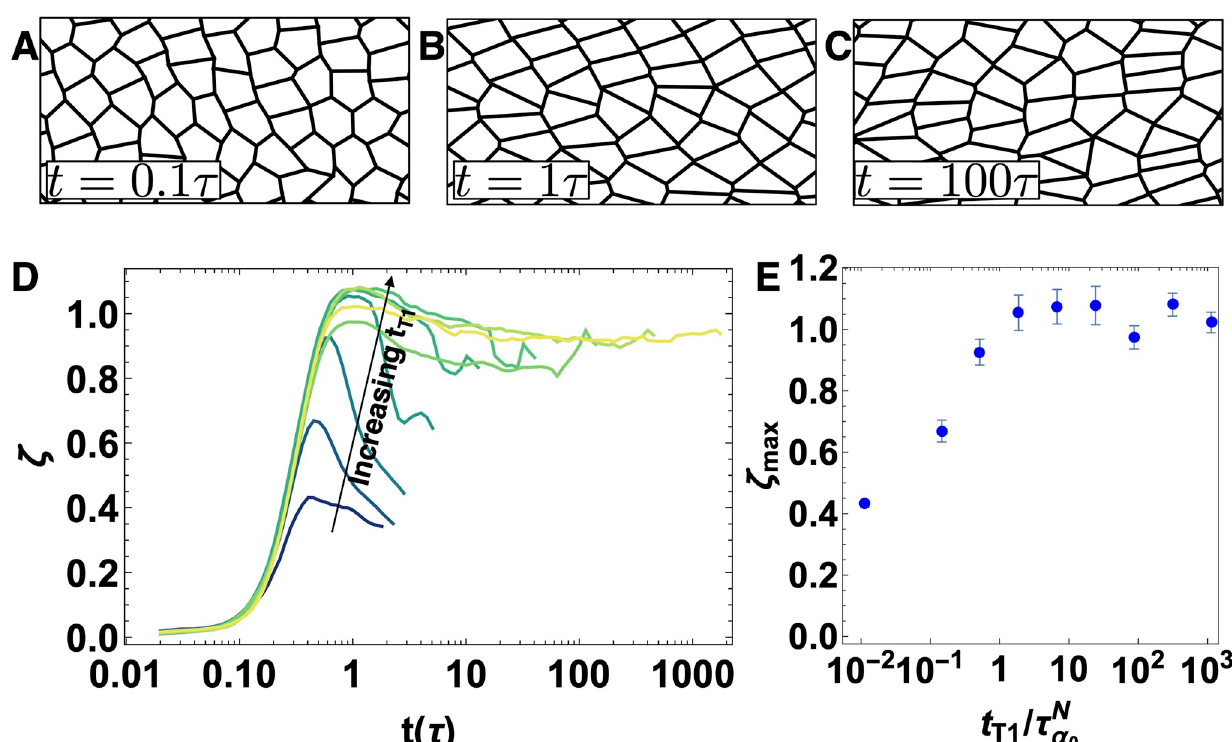
Fig 4. Counting very short edges as a proxy for many-fold vertices. Snapshots of configurations at (A) t = 0.1, (B) t = 1, and (C) t = 100 τ for t for a tissue with p 0 = 3.74, T = 0.02, N = 256 and γ 0 = 1.0. D) Number of very short edges per cell ξ for an anisotropic tissue as a function of time. Shaded lines represent different T1 delay times t = 0, 0.13, 0.46, 1.67, 5.99, 21.5, 77.4, 278.2 and 1000 τ (dark green to yellow), for a tissue with T 1 t N ¼ 0 : 89 t (cid:0) p ¼ 3 : 74 , T = 0.02, N = 256 and γ 0 = 1.0. E) Ensemble-averaged maximum value of ξ over a simulation timecourse ( ξ 0 a 0 time t T 1 normalized by t N . The average is taken over 10 independent simulations, and error bars correspond to one standard error. a 0